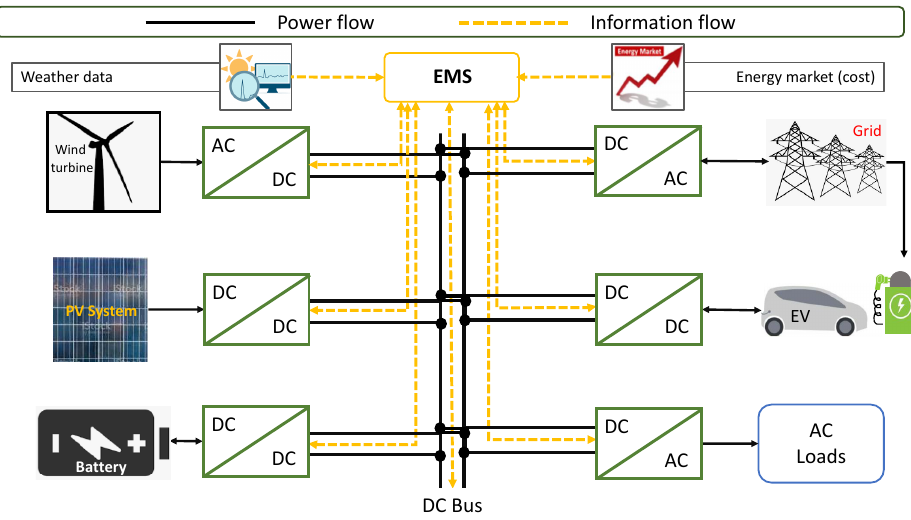
Figure 1. Structure of the home MG considering an EV as backup energy